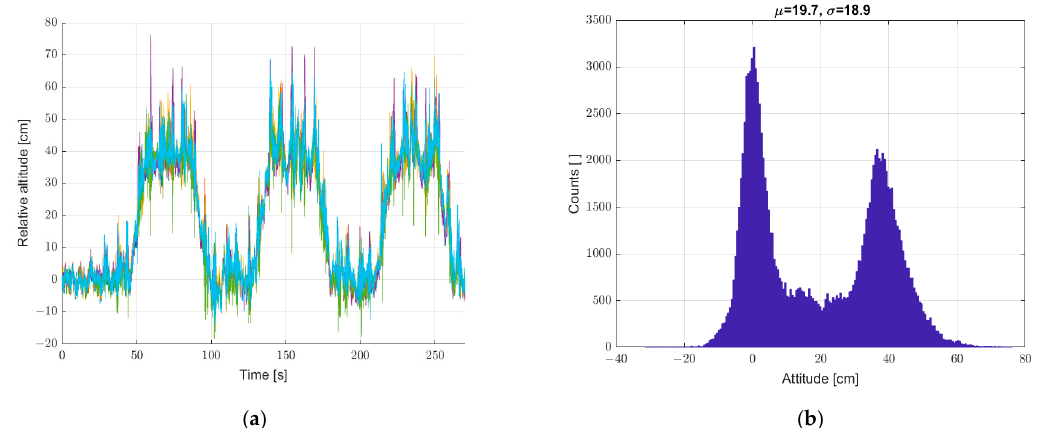
Figure 16. ( a ) Graph over time from 6 + 1 sensors, and ( b ) histogram. Dynamic measurements— sensor array in motion, with additional variable crosswind gusts.